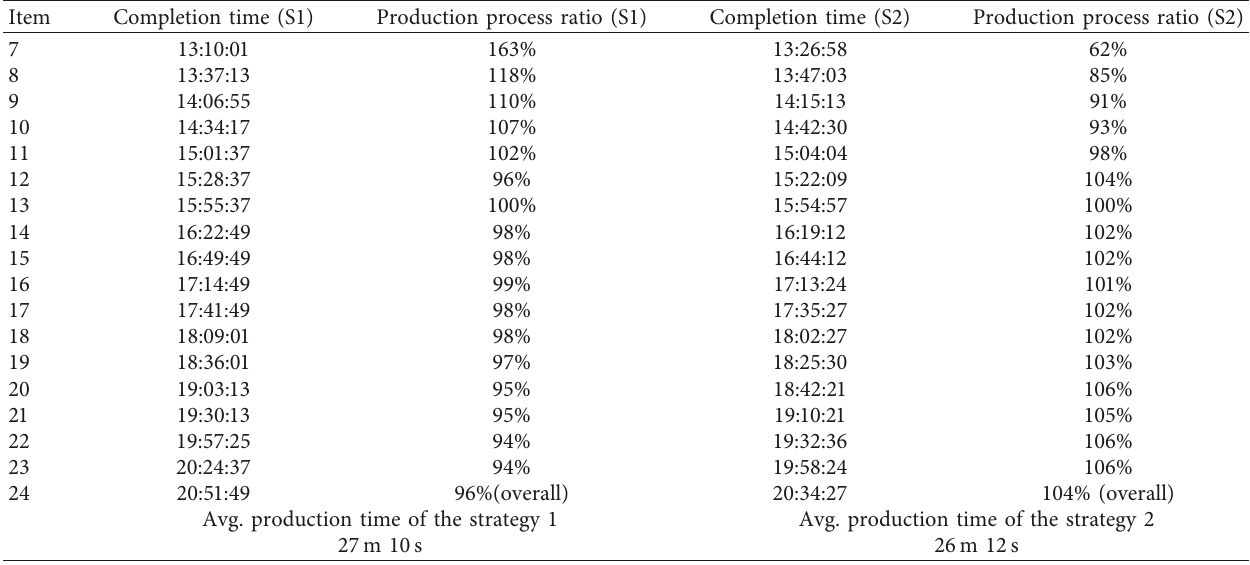
Table 4: Comparison of production process